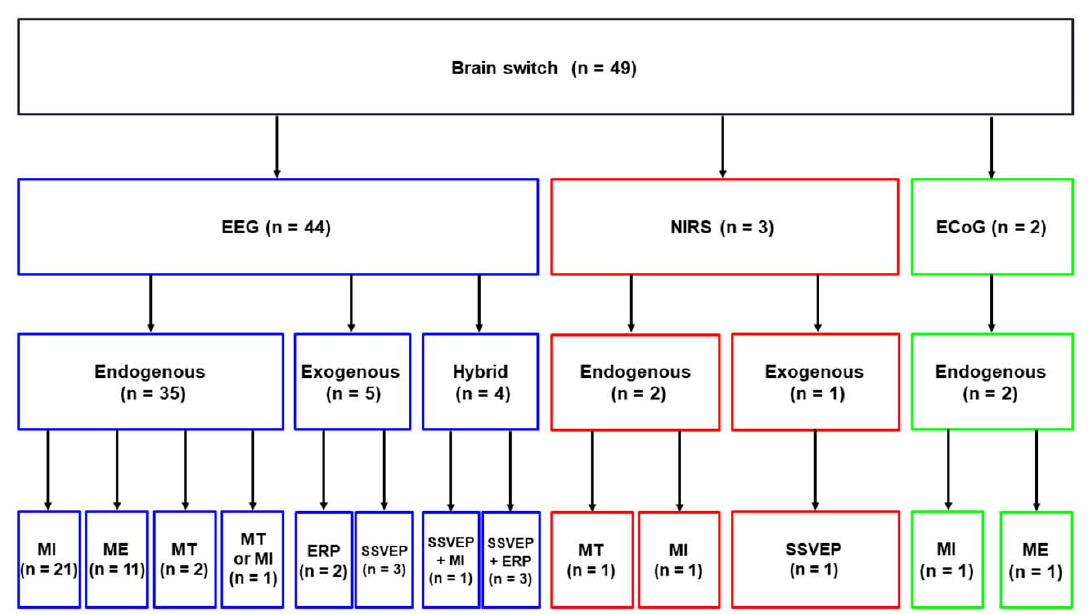
Figure 2. Taxonomy of brain-switches. N indicates the number of articles included in each category. MT indicates mental task except for motor imagery (MI) or motor execution (ME), such as mental multiplication, letter composing, object rotation, and number counting.